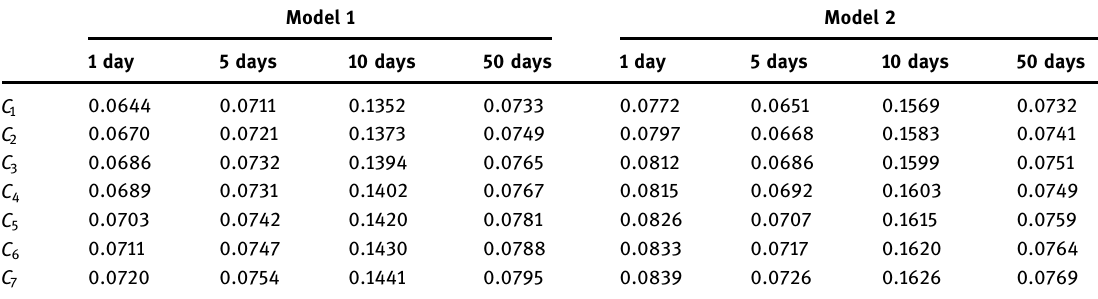
Table 6: RMSE for 1, 5, and 10 days ahead predictions in 50 - day out - of - sample window using 30/1/2017 – 18/2/2021 data